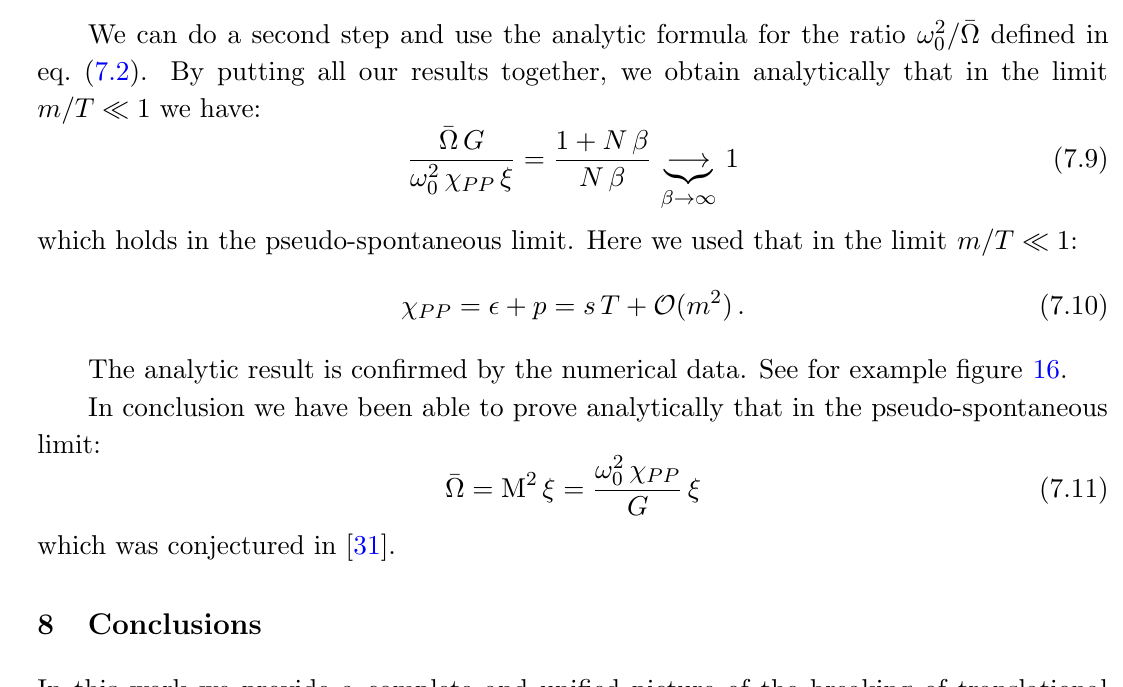
Figure 16 . The numerical check of the relation in eq.